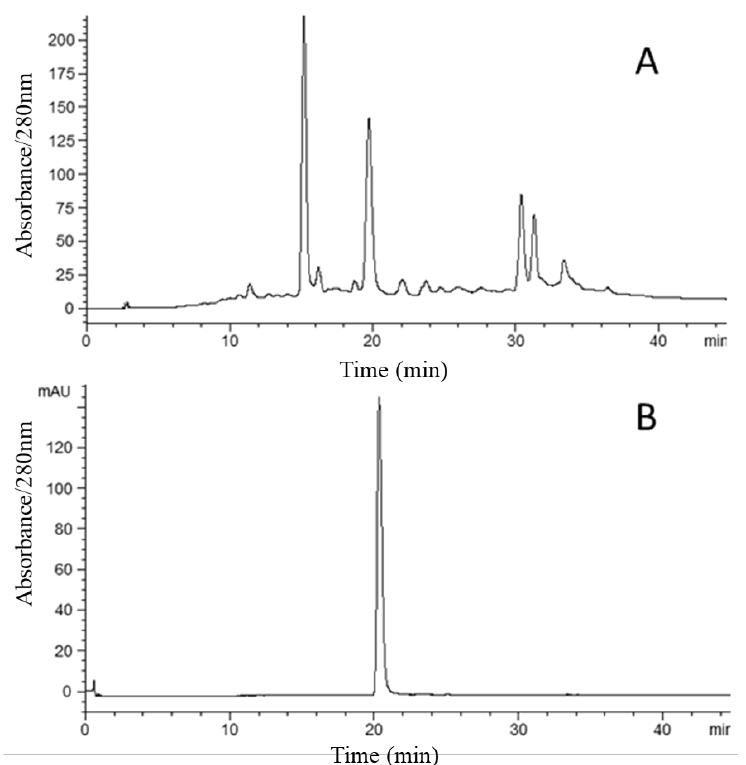
Figure 3. HPLC chromatograms at 280 nm. ( A ) Chromatogram of the Acanthopanax sessiliflorus acidified methanol extract; ( B ) cyanidin 3-xylosyl-galactoside from Acanthopanax sessiliflorus following purification by means of high-speed counter-current chromatography (HSCCC) (Figure 4).